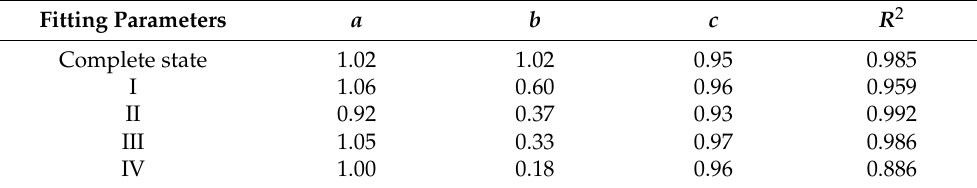
Table 3. Exponential fitting